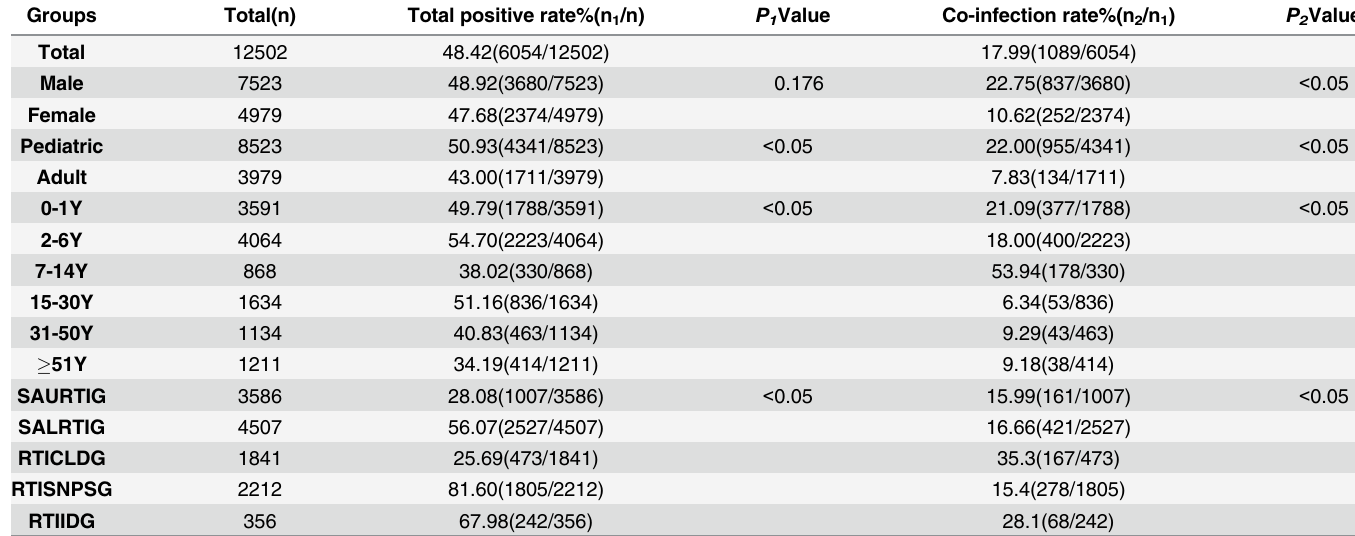
Table 1. The total PDRs and CIRs of respiratory pathogens from July 2009 to June 2014.